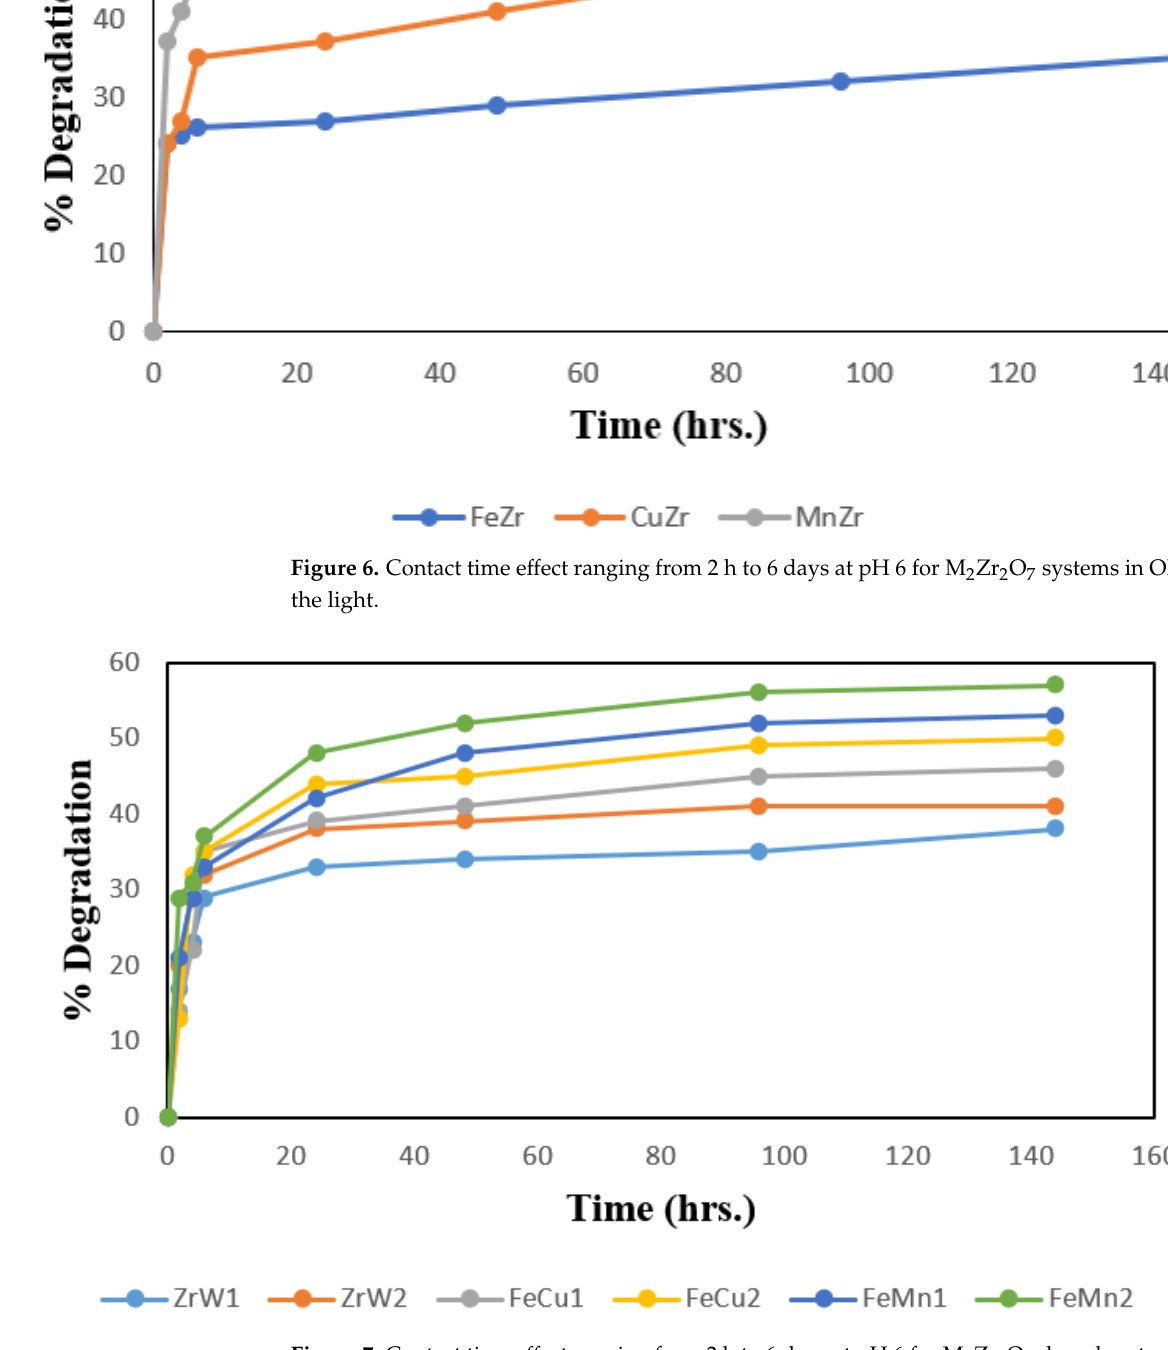
Figure 7. Contact time effect ranging from 2 h to 6 days at pH 6 for M 2 Zr 2 O 7 doped systems in OMW under the light.